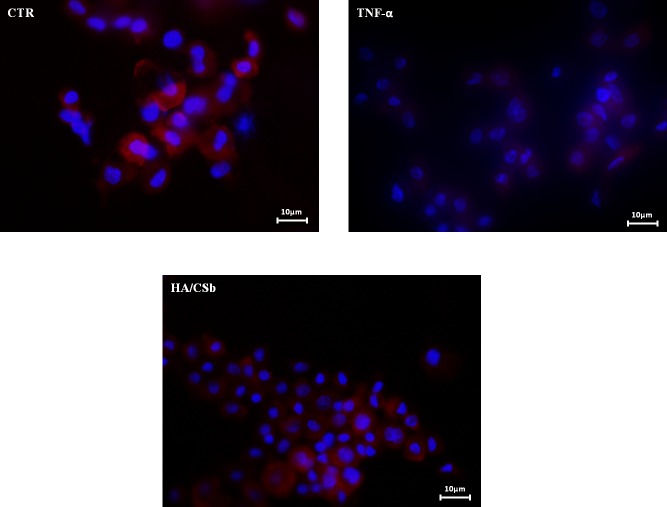
Effects of the HA/CSb formulation on ZO-1 expression in a human bladder 3D cell model challenged with TNF-α.Immunofluorescence image shows ZO-1 (red) expression after 48 h of HA/CSb treatment. Nuclei are shown in blue.